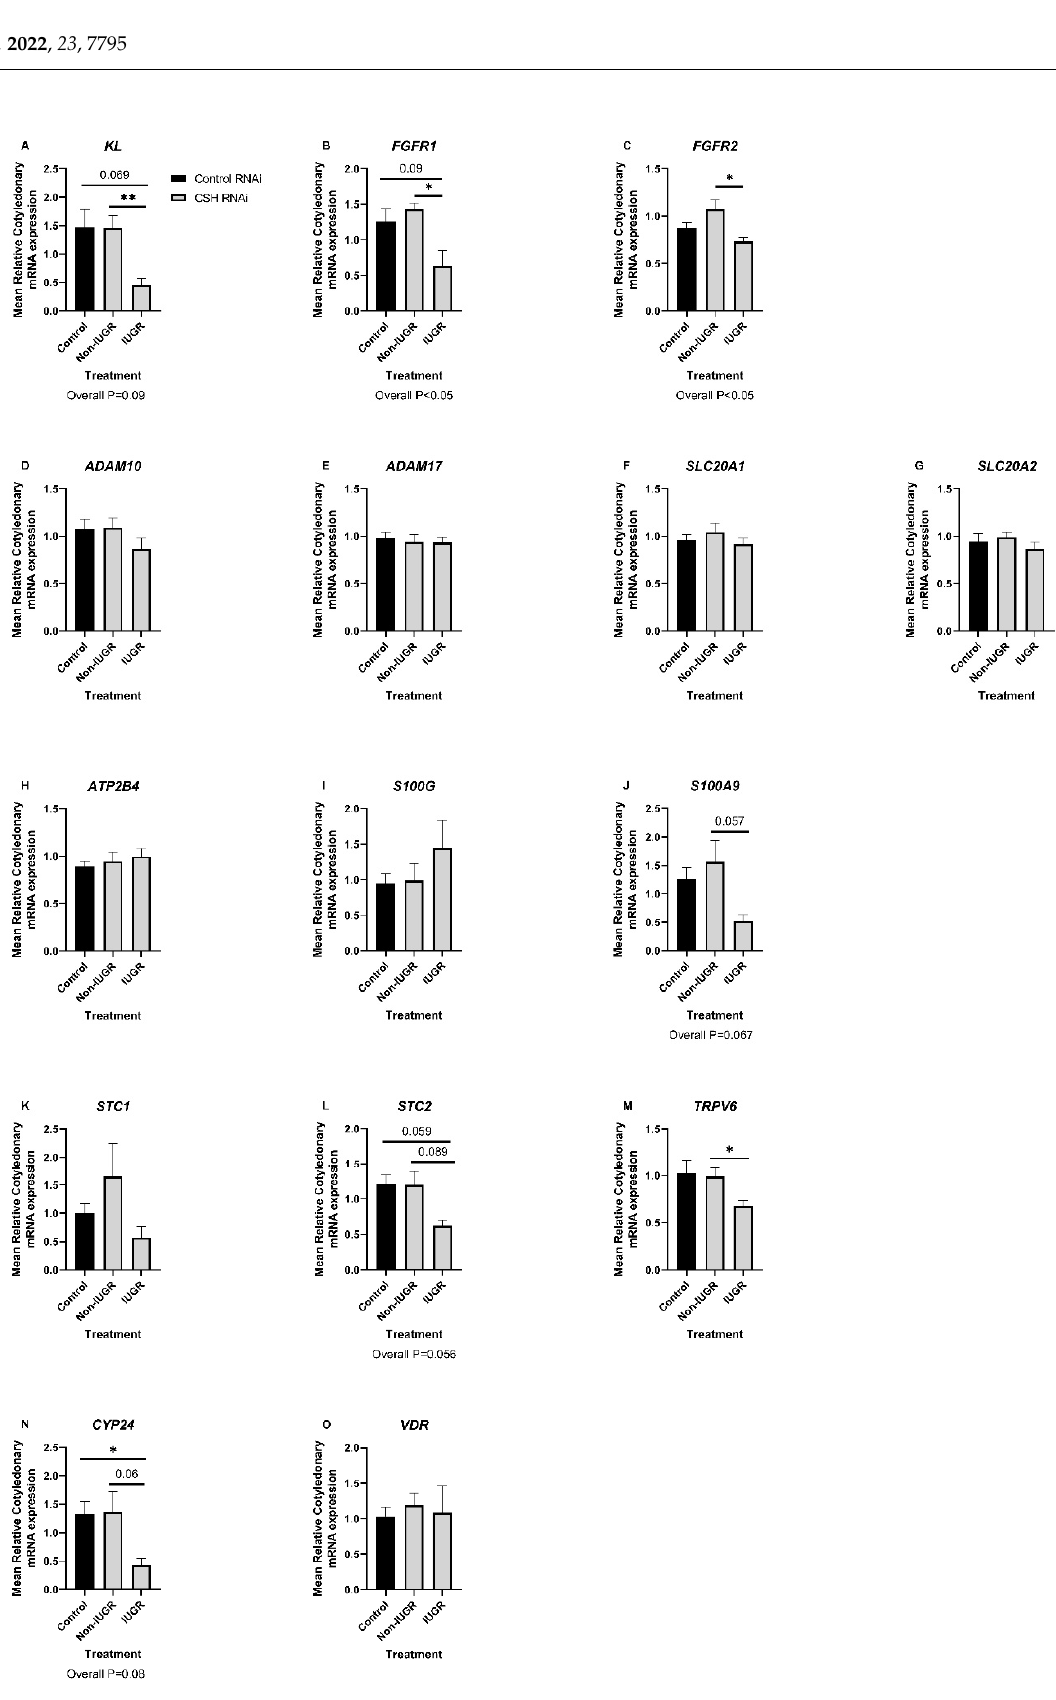
Figure 3. Relative expression of candidate mRNAs with roles in calcium, phosphate, and vitamin D signaling, transport, and metabolism in cotyledons from Control RNAi, CSH RNAi Non-IUGR, and CSH RNAi IUGR pregnancies. Data are presented as means ± SEM. Control RNAi, n = 10; CSH RNAi Non-IUGR, n = 6; CSH RNAi IUGR, n = 4. CSH, chorionic somatomammotropin; IUGR, intrauterine growth restriction; RNAi, RNA interference. * p < 0.05, ** p < 0.01.